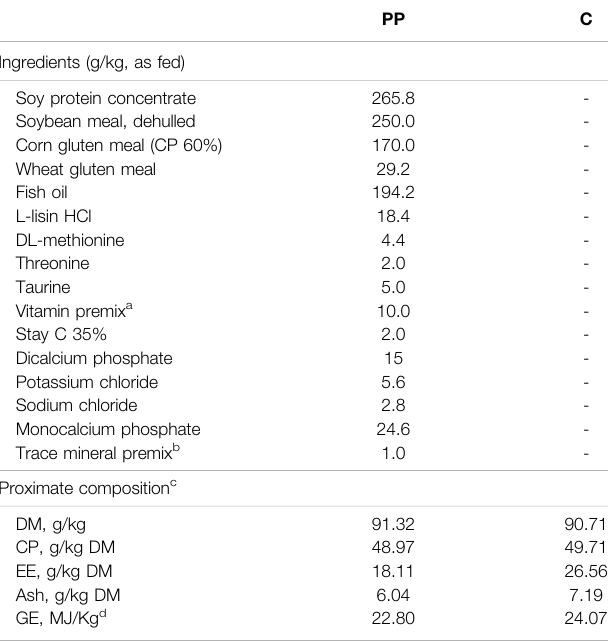
TABLE 1 | Feed ingredients (g/kg, as fed) and proximate composition of the experimental